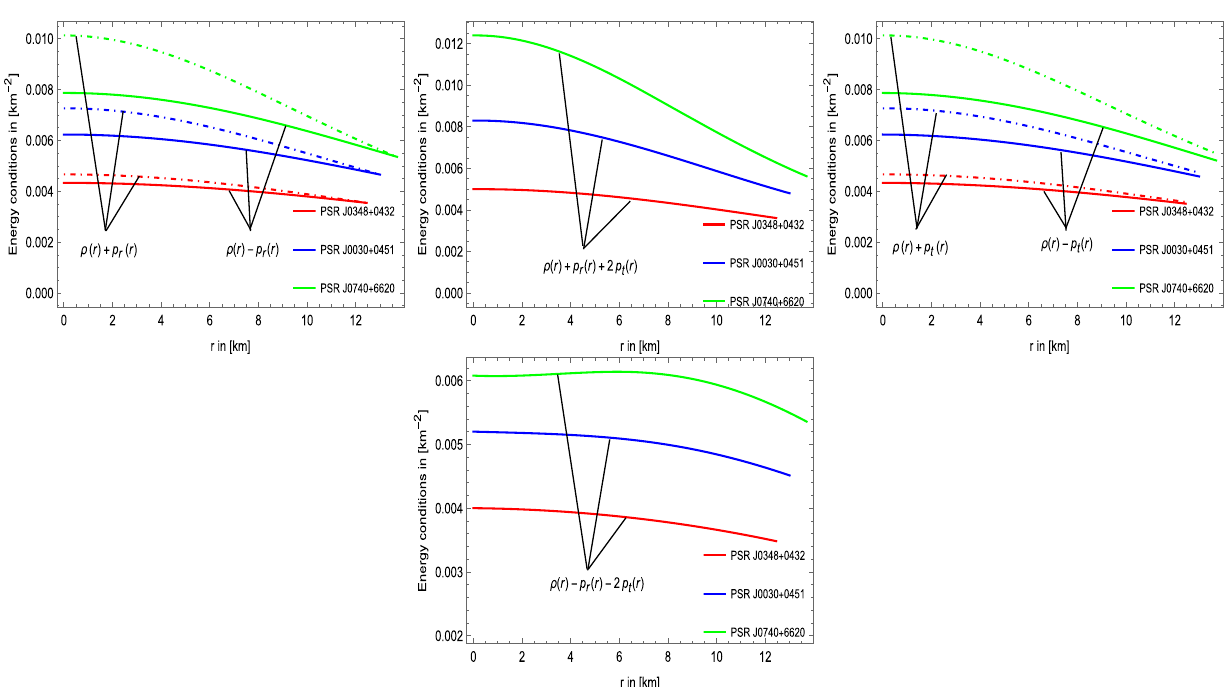
Fig. 2 Behaviour of the energy conditions against the radial coordinate r of our stellar model for three heavy pulsars. For plotting these graphs, we use the numerical values of the constant parameters given in Table 1